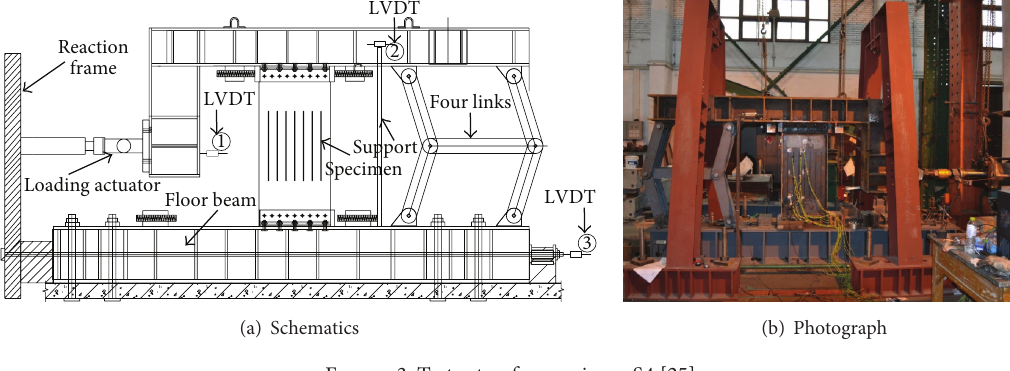
Figure 3: Test setup for specimen S4 [25].